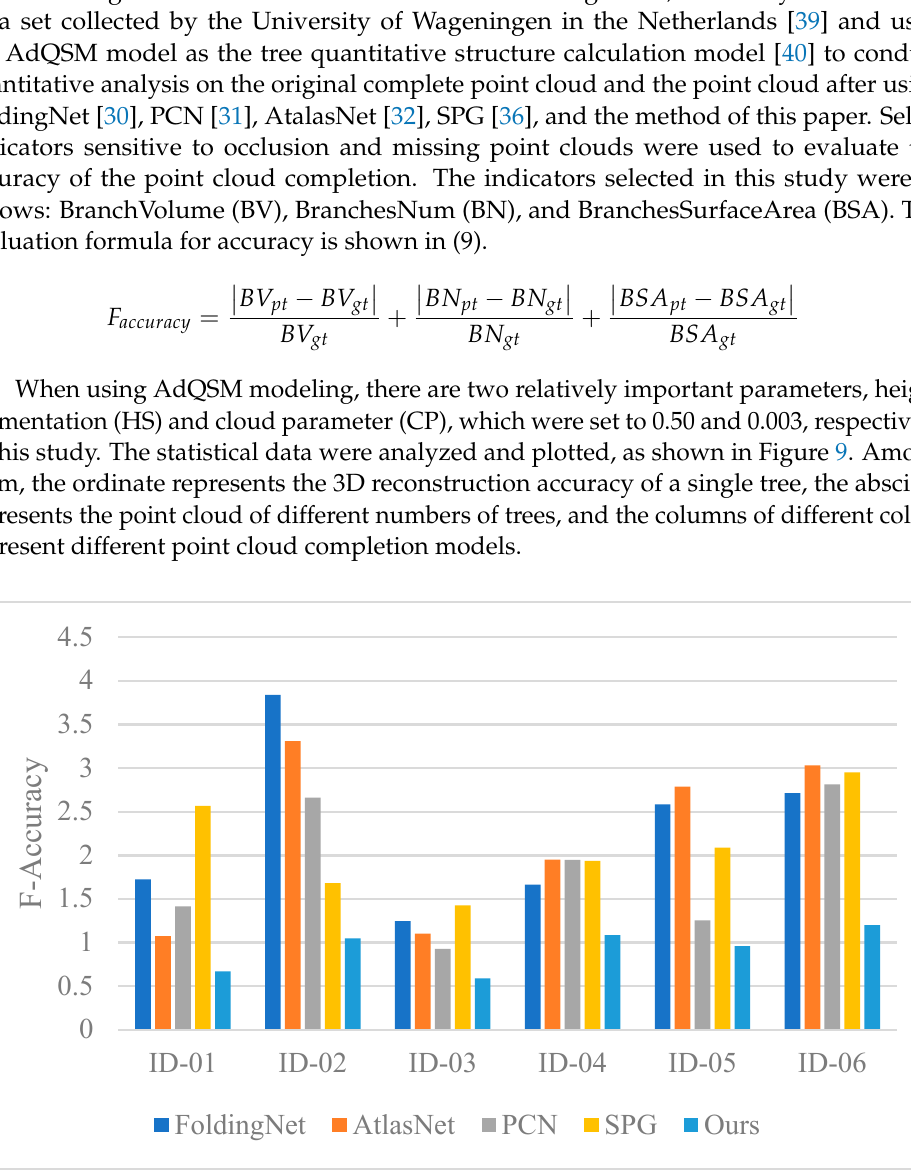
Figure 9. Quantitative analysis accuracy of single-tree after point cloud completion of various mod- els.